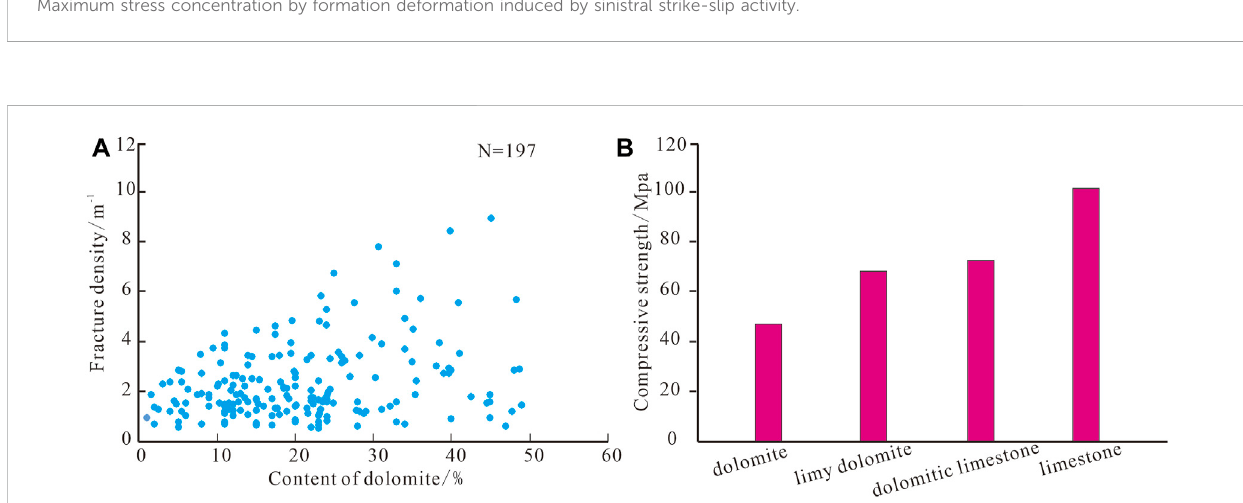
Maximum stress concentration by formation deformation induced by sinistral strike-slip